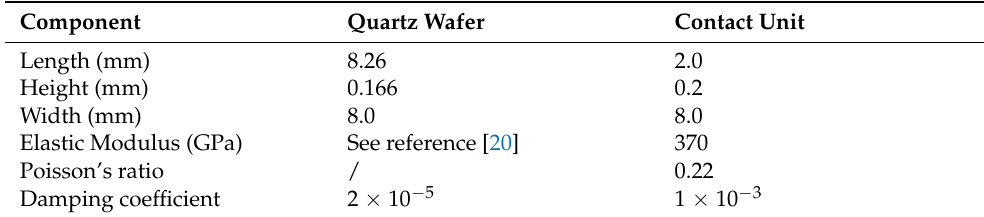
Table A1. Parameters and material properties of the